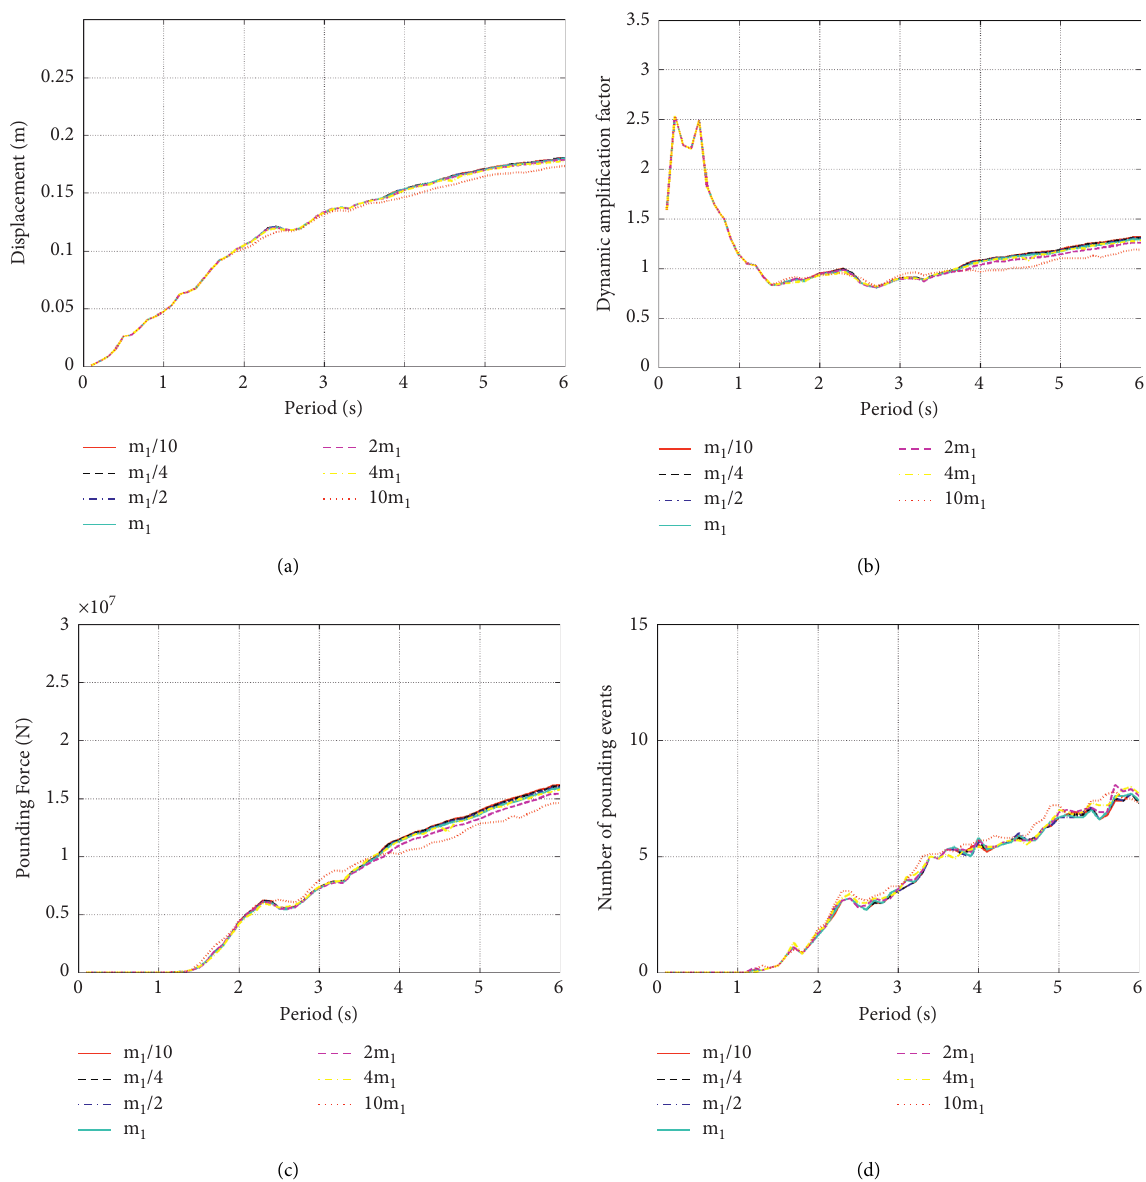
Figure 12: Average spectrum analysis results with different abutment mass. (a) Displacement spectrum. (b) Dynamic amplification factor spectrum. (c) Pounding force spectrum. (d) Number of pounding event response